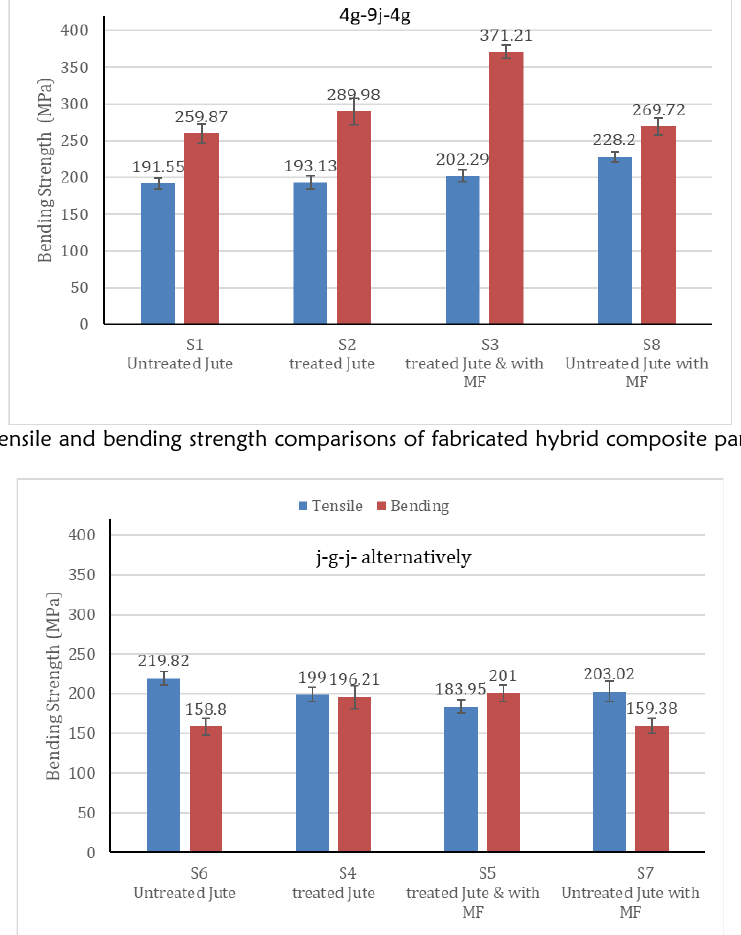
Figure 12: Average tensile and bending strength comparisons of fabricated hybrid composite panels having g-j-g-j-- (one by one) stacking sequence.